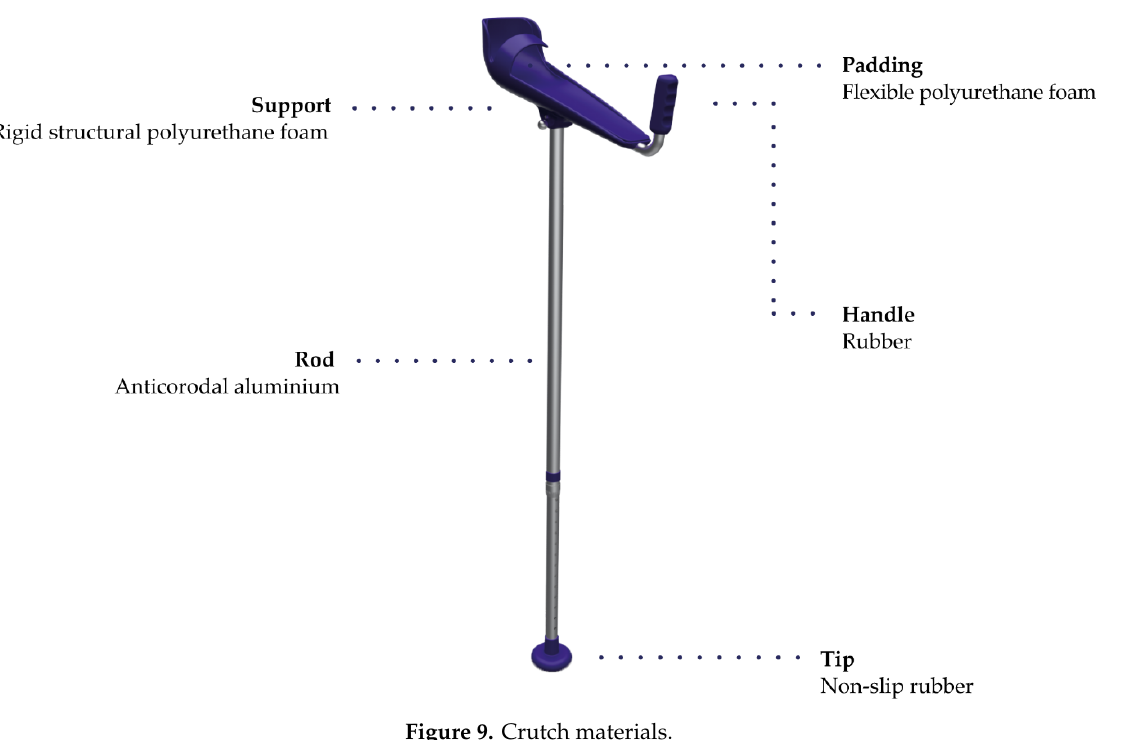
Figure 9. Crutch materials.